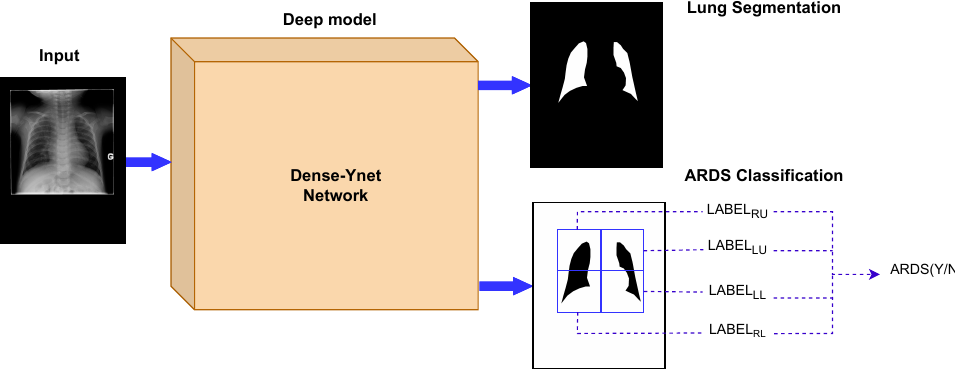
Figure 2. The Dense-Ynet model takes advantage of the interaction between the segmentation and classification tasks by performing them simultaneously. The features from the original and lung-segmented images are concatenated and utilized to classify ARDS